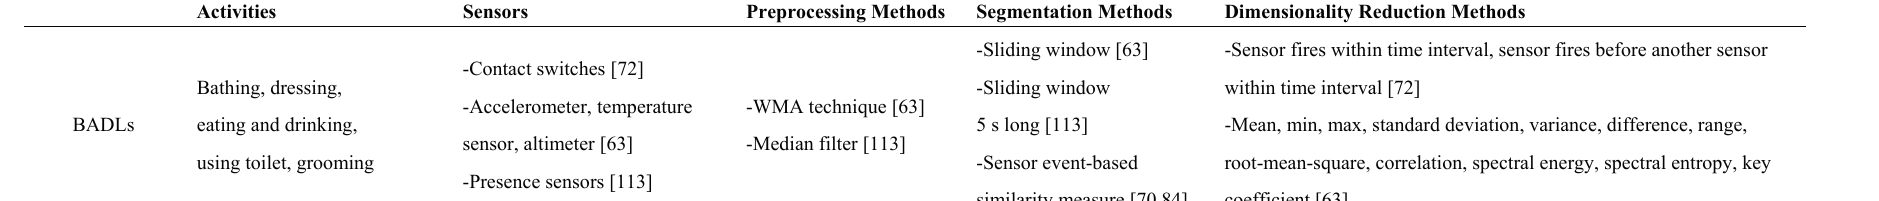
Table 7. Data processing approaches correspondence with relevant sensors and monitored